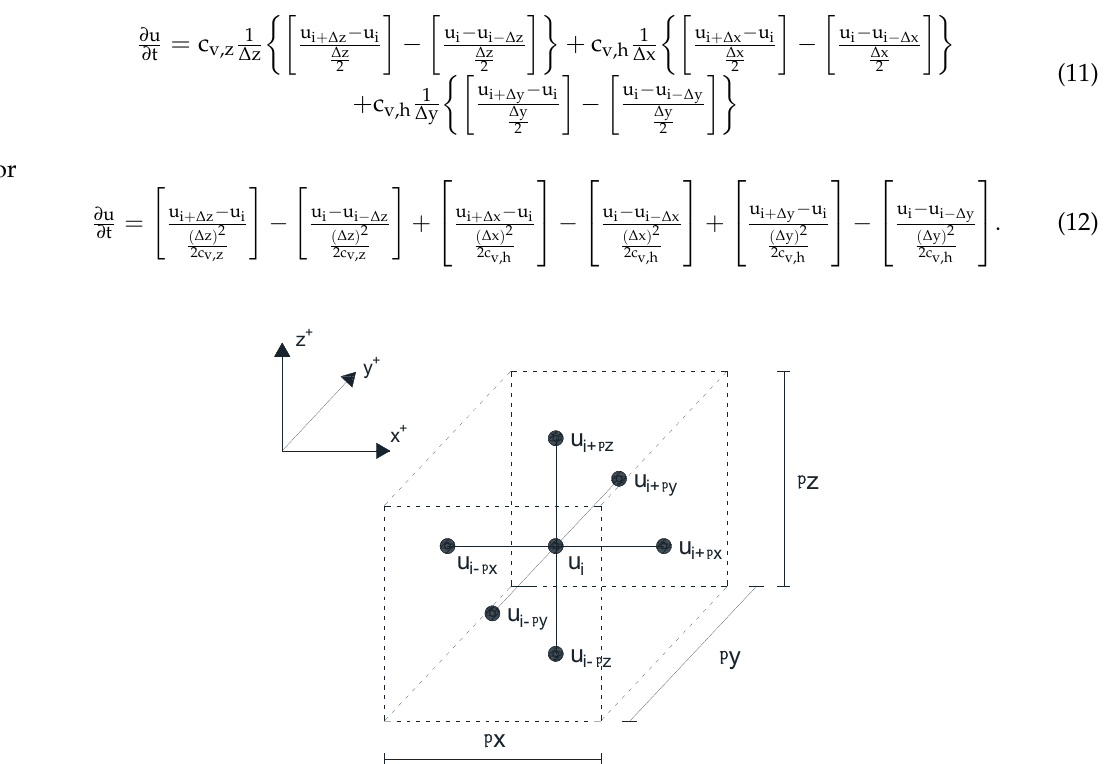
Figure 3. Nomenclature of the element cell of the 3D rectangular consolidation model.